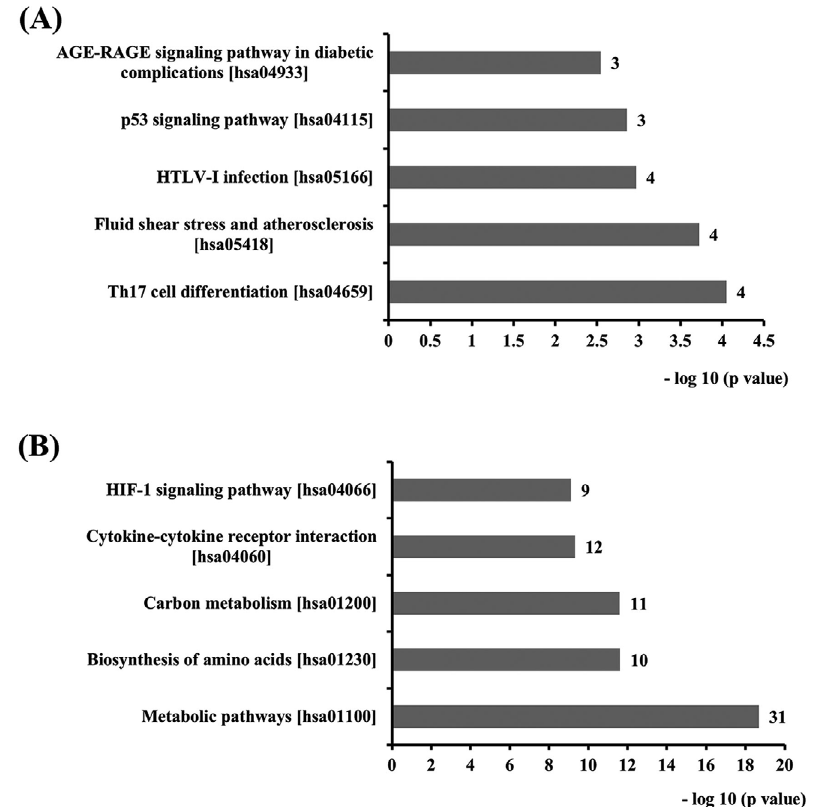
Figure 2- The top 5 KEGG pathways involving DEGs on day 1 (A) and day 14 (B), numbers at the right of each column indicate the number of hit genes in the pathway